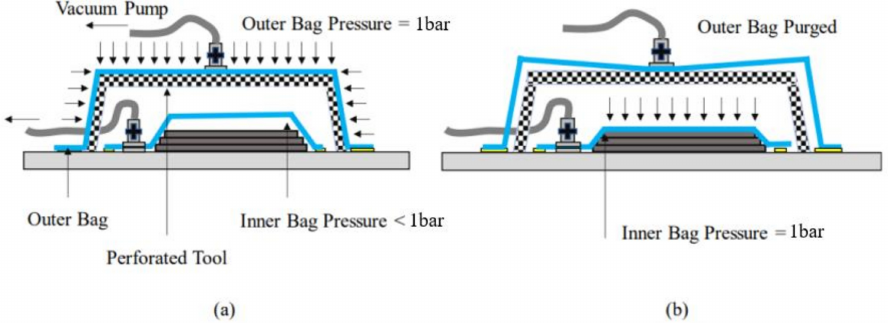
Figure 3. Schematics of a flexible double-vacuum-bagging setup with a perforated tool during ( a ) de- gassing phase and ( b ) compaction phase. Ref. [30] Reprinted with permission from Springer Nature.